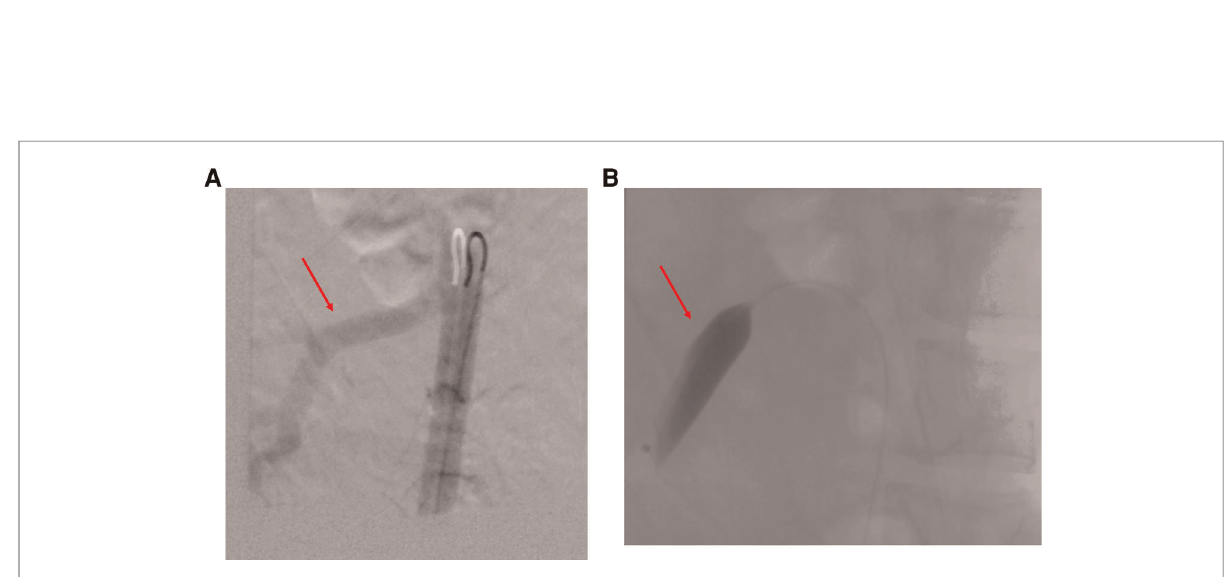
FIGURE 2 ( A ) Intraoperative left renal artery angiography (red arrow: main renal artery). ( B ) Endovascular clamping of the left renal artery (endovascular balloon occluding the main renal artery).